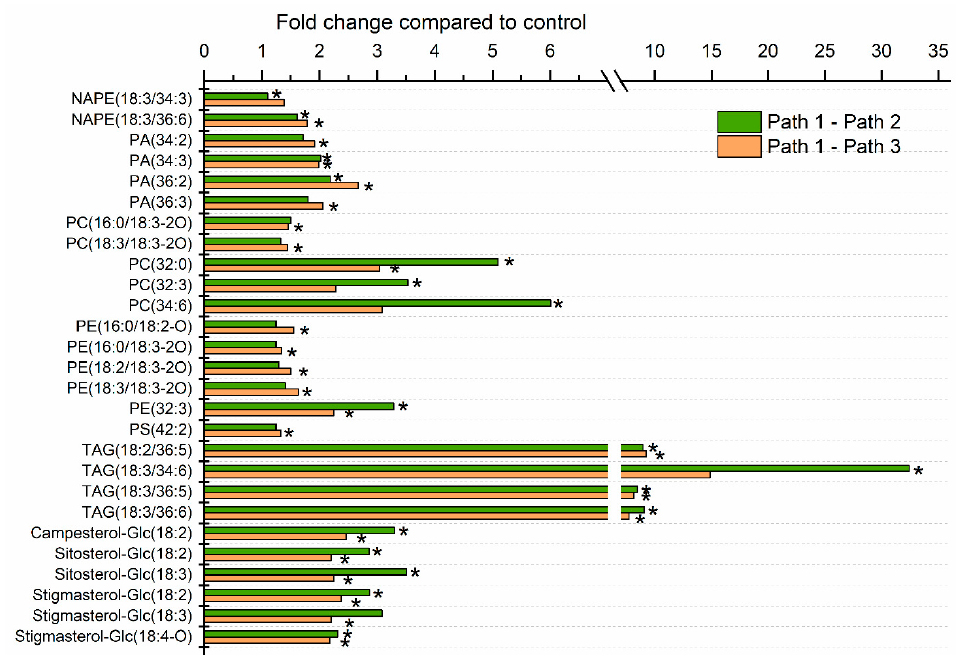
Figure 5. Extra-plastidic leaf phospholipids, acyl sterol glucosides, and triacylglycerols, significantly altered by heat treatment. Values represent the level of each lipid under heat treatment over the level